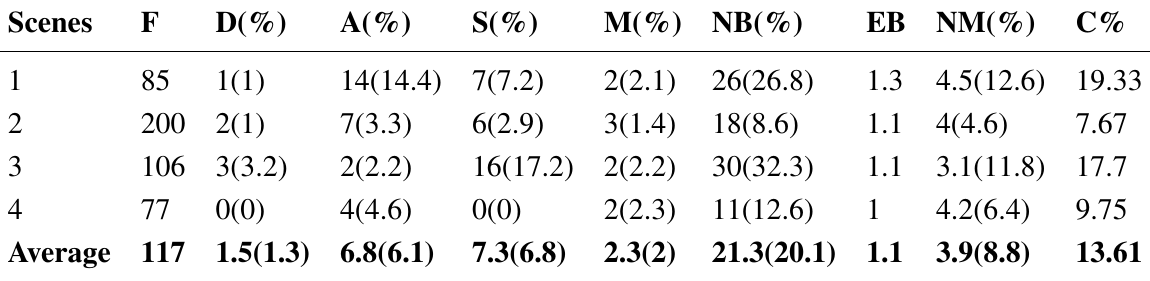
Table 5. Estimation of manual interactions to generate the building map using the GUI from automatically-extracted building footprints in 2007. F = number of automatically-extracted footprints, D = number of deletions for removing false buildings (trees), A = number of additions for inclusion of missing true buildings, S = number of split operations, M = number of merge operations, NB = number of detected buildings being edited to be acceptable, EB = number of editions per edited building, NM = number of mouse clicks per edition and C% = percentage of clicks to total